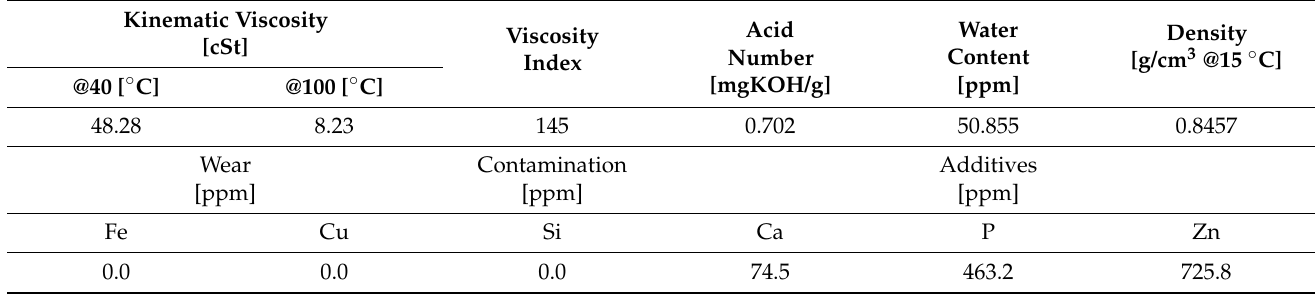
Figure 2. Schematic image of the test rig using by oil quality sensor. Table 3. Properties of the new ISO VG 46 hydraulic oil.